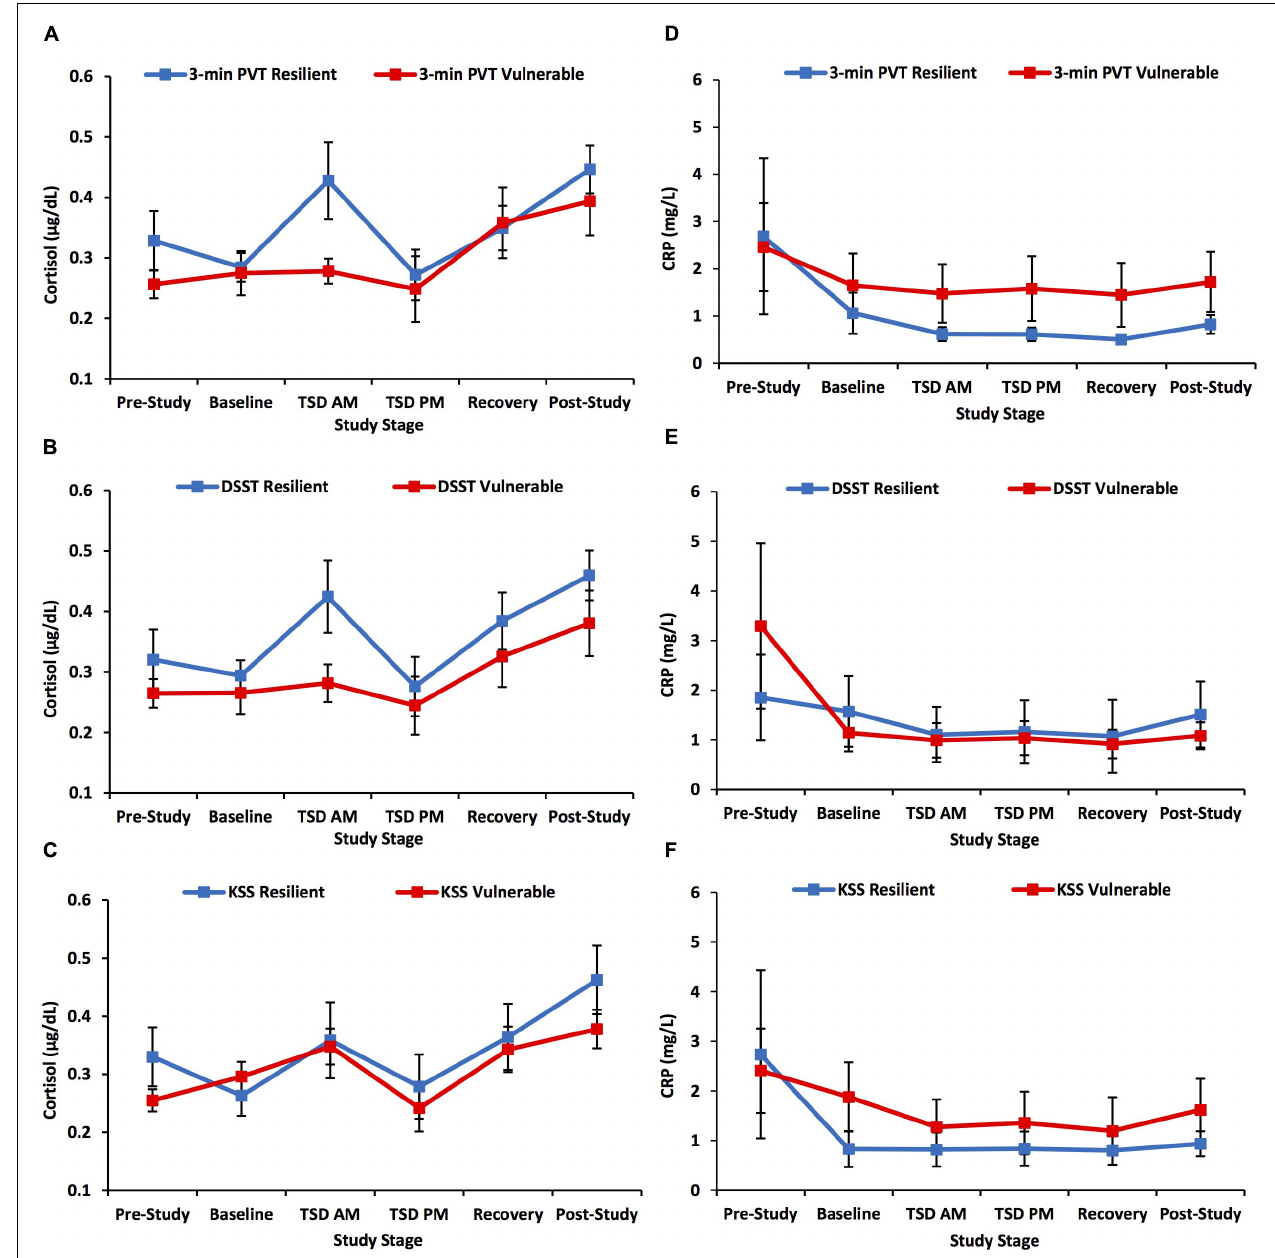
FIGURE 2 | Cortisol and C-reactive protein (CRP) changes across the study defined by a median split on 3-min Psychomotor Vigilance Test (PVT) lapses and errors, Digit Symbol Substitution Test (DSST) total number correct, and Karolinska Sleepiness Scale (KSS) scores. The left panel of graphs shows the pattern of change in cortisol across the study and the right panel of graphs shows the pattern of change in CRP across the study for neurobehavioral measures. Resilient and vulnerable groups were defined by a median split on (A,D) 3-min PVT lapses and errors; (B,E) DSST total number correct; and (C,F) KSS scores. There were no significant findings for the 3-min PVT, DSST, or KSS analyses. N = 15 in the recovery resilient points in (A,B,D,E) and in the recovery vulnerable points in (C,F) due to one participant withdrawn from the study during recovery night 1; N = 15 in the post-study resilient points in (D–F) due to a blood collection error; all other data points are N = 16. Data are not transformed and are presented as mean ±